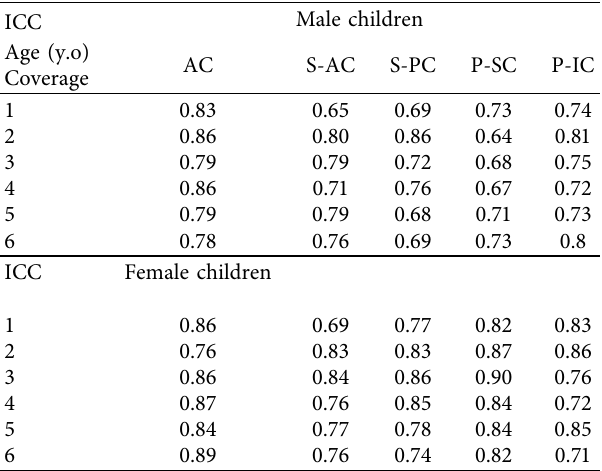
Table 4: Intraclass correlation values of normal FH coverage by different acetabular regions in male and female children under